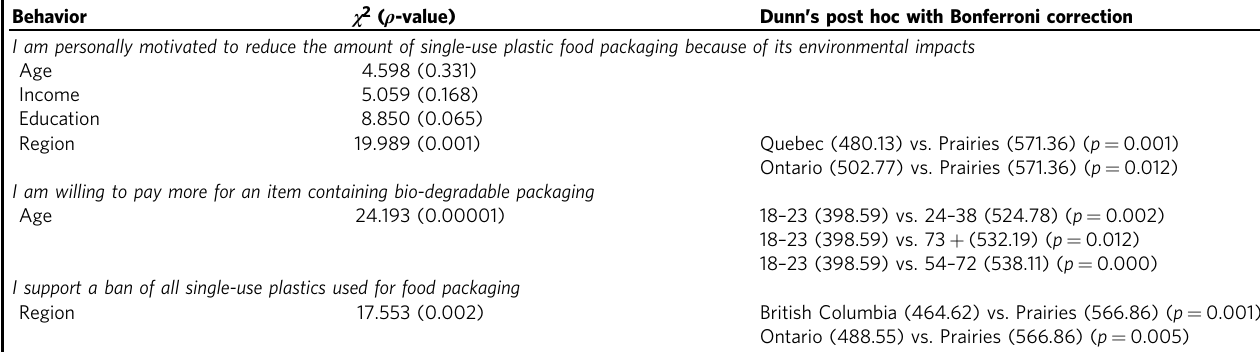
Table 2 Consumer behavioral traits towards single-use plastic packaging. Behavior χ 2 ( ρ -value) Dunn ’ s post hoc with Bonferroni